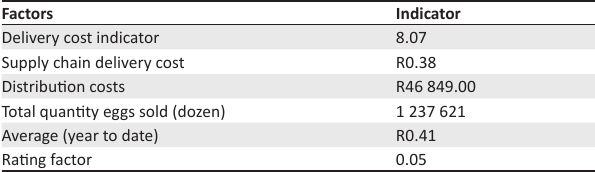
TABLE 24: Delivery